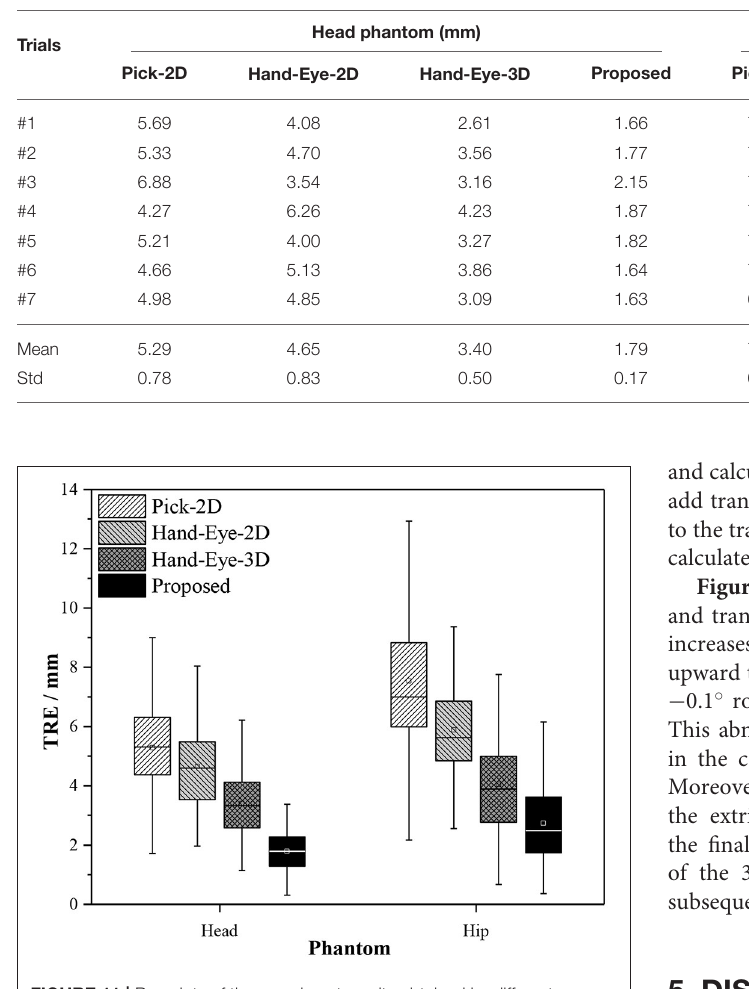
FIGURE 11 | Box plots of the experiment results obtained by different calibration methods used in image-to-patient